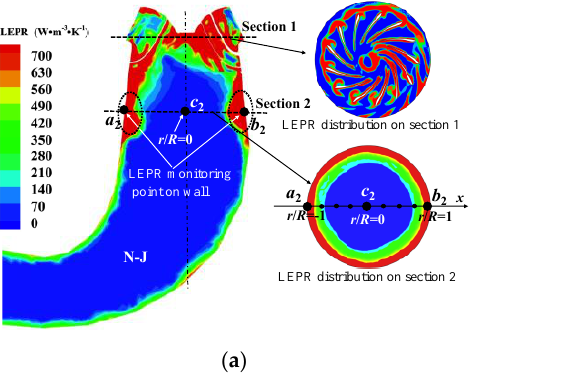
Figure 7. LEPR distribution in runner and draft tube with or without J-groove when Q * = 53%. ( a ) The entropy production rates without J-groove, ( b ) The entropy production rates with J-grooves. Taking the center of Section 2 as the origin point, R is the radius of Section 2, and r